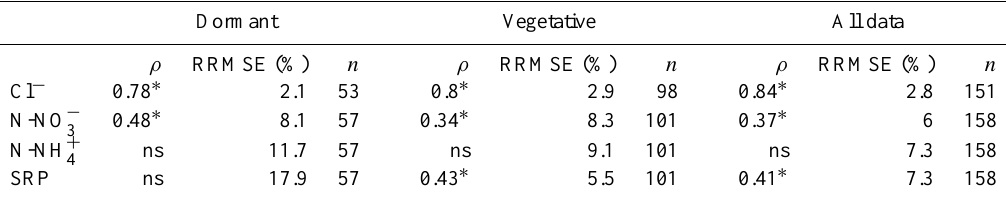
Table 2. Spearman ρ coefficient between stream water and riparian groundwater solute concentrations for each period and for the whole data set collected at the Font del Regàs during the study period. The relative root-mean-square error (RRMSE) indicates divergences from the 1 : 1 line. n = number of cases. ∗ p < 0 . 01. ns: not significant.